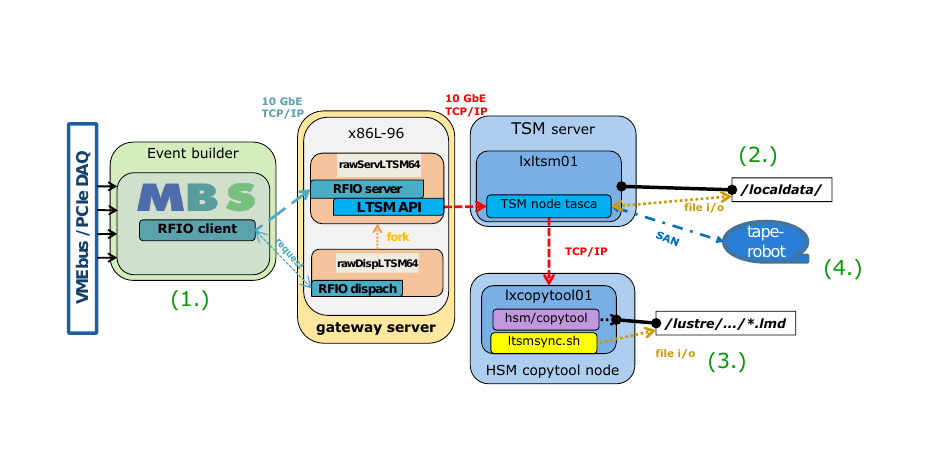
Figure 4. Functionality of the RFIO-LTSM gateway for MBS. See main text for